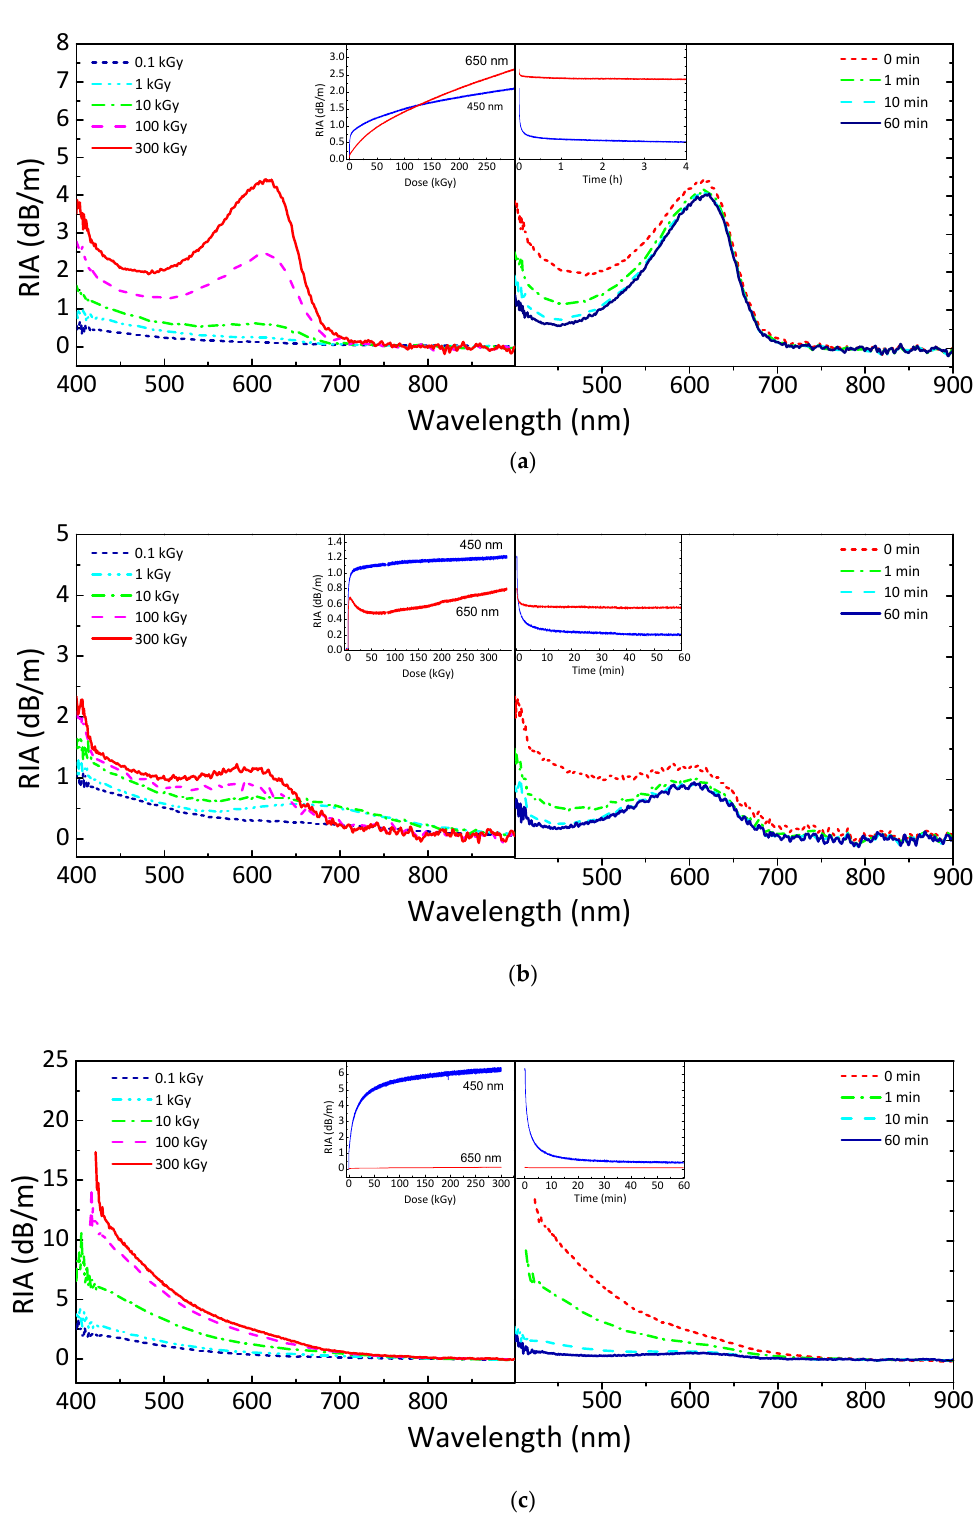
Figure 3. Radiation-induced attenuation (RIA) spectral growth during the irradiation (left) and spectral decrease during the recovery (right) in the high -OH ( a ), the medium -OH ( b ), and the low -OH ( c ) sample. Both insets show their respective RIA kinetics at the wavelengths of 450 nm and 650